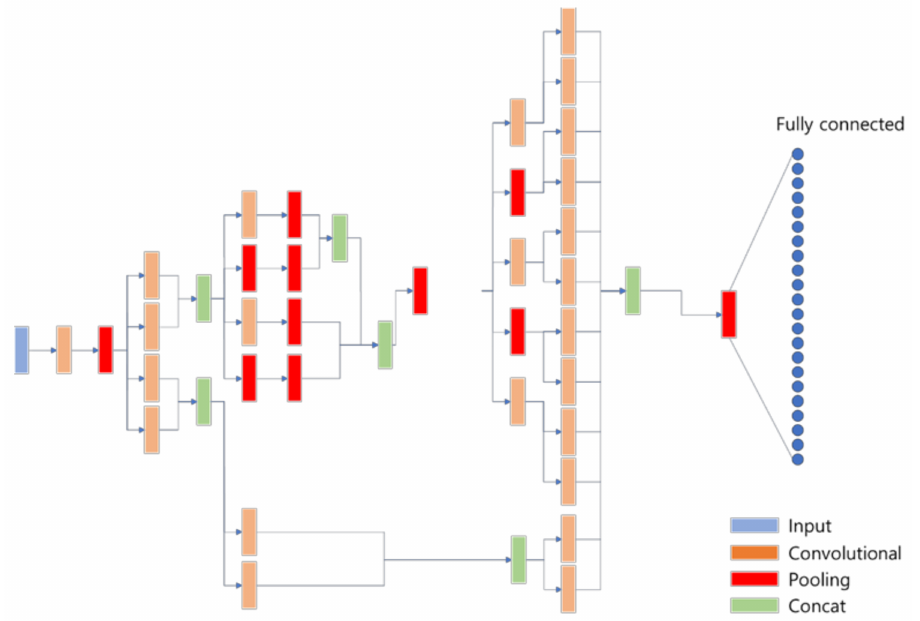
Figure 7. Convolution Configuration